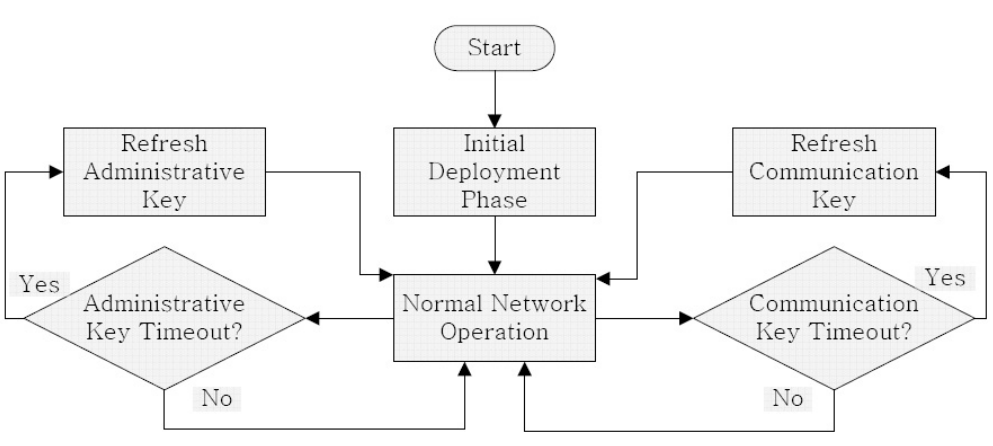
Figure 3. Flowchart of our proposed